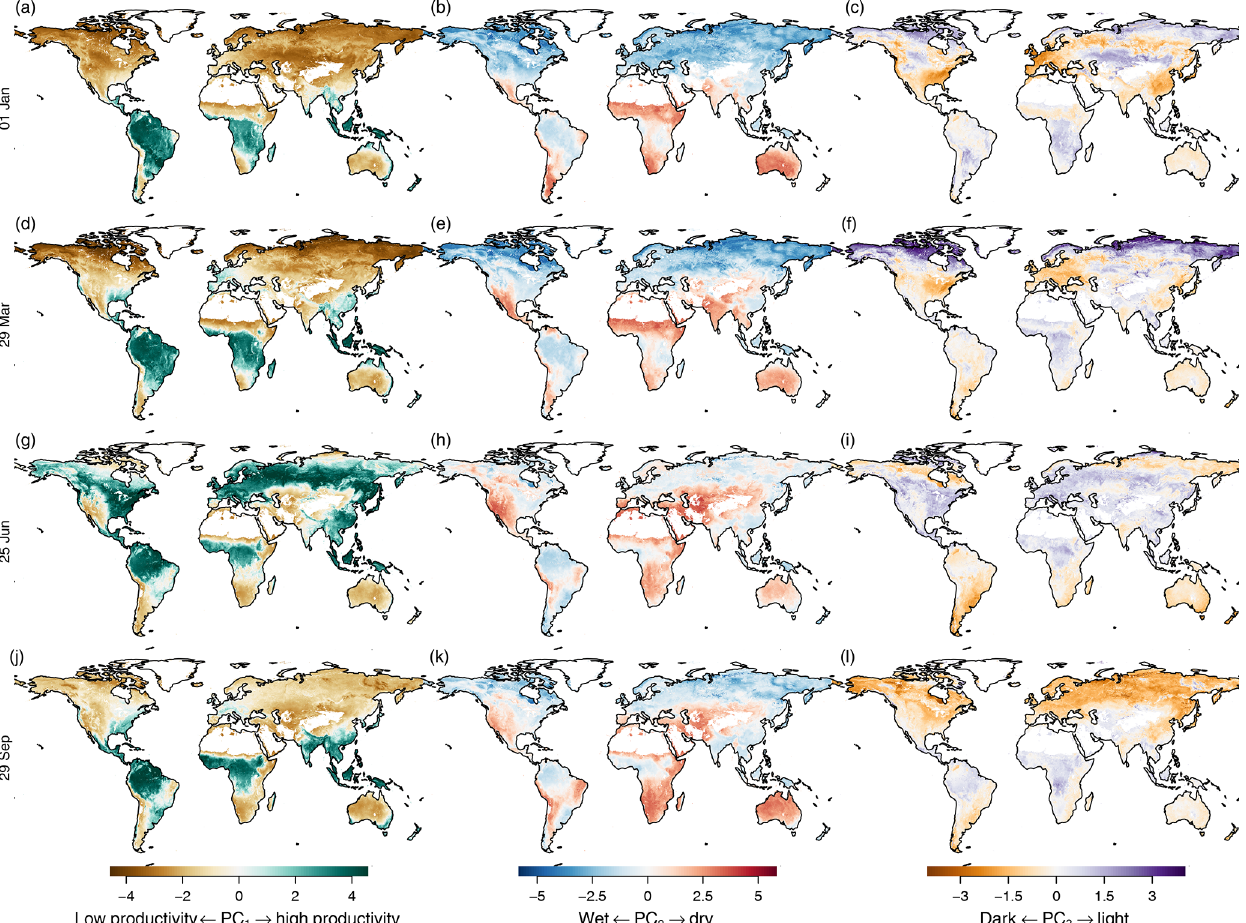
Figure 6. Mean seasonal cycle of the first three principal components (in columns) during the seasons (in rows). Left column: first principal component. Middle column: second principal component. Right column: third principal component. Rows from top to bottom: equally spaced intervals during the year. Values have been clamped to 0 . 7 times their range to increase